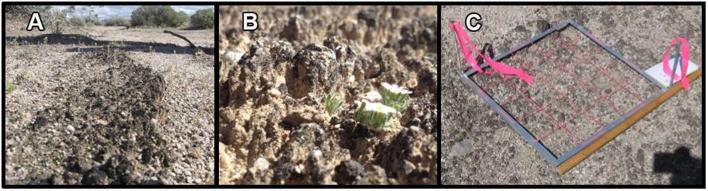
Images of black-crusted biological soils crusts (BSCs) in the western section of the Mojave National Preserve showing (A) example surface coverage at the high-density site, (B) pinnacled structure of the BSCs, and (C) the grid used for measuring BSC surface coverage.